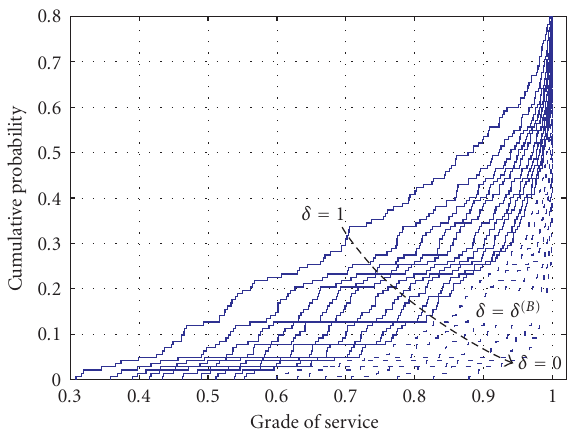
Figure 6: Empirical CDF for grade of service depending on the switching parameter δ . Dotted curves represent the cases with the broadcast network in overload.